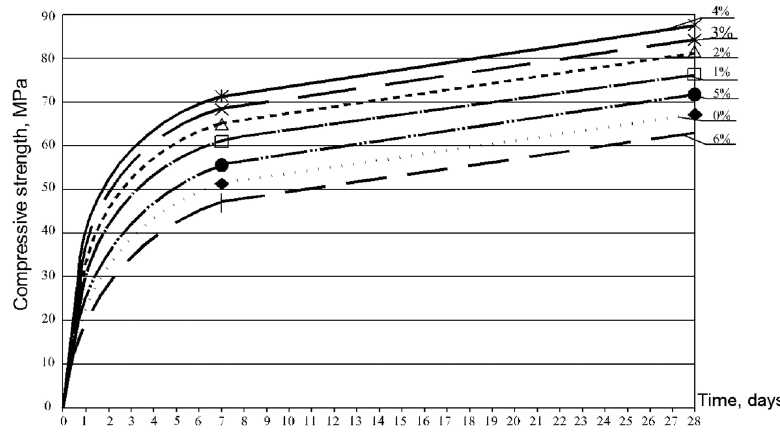
Figure 6: Kinetics of strength of dispersed and fi ber - reinforced cement stone.